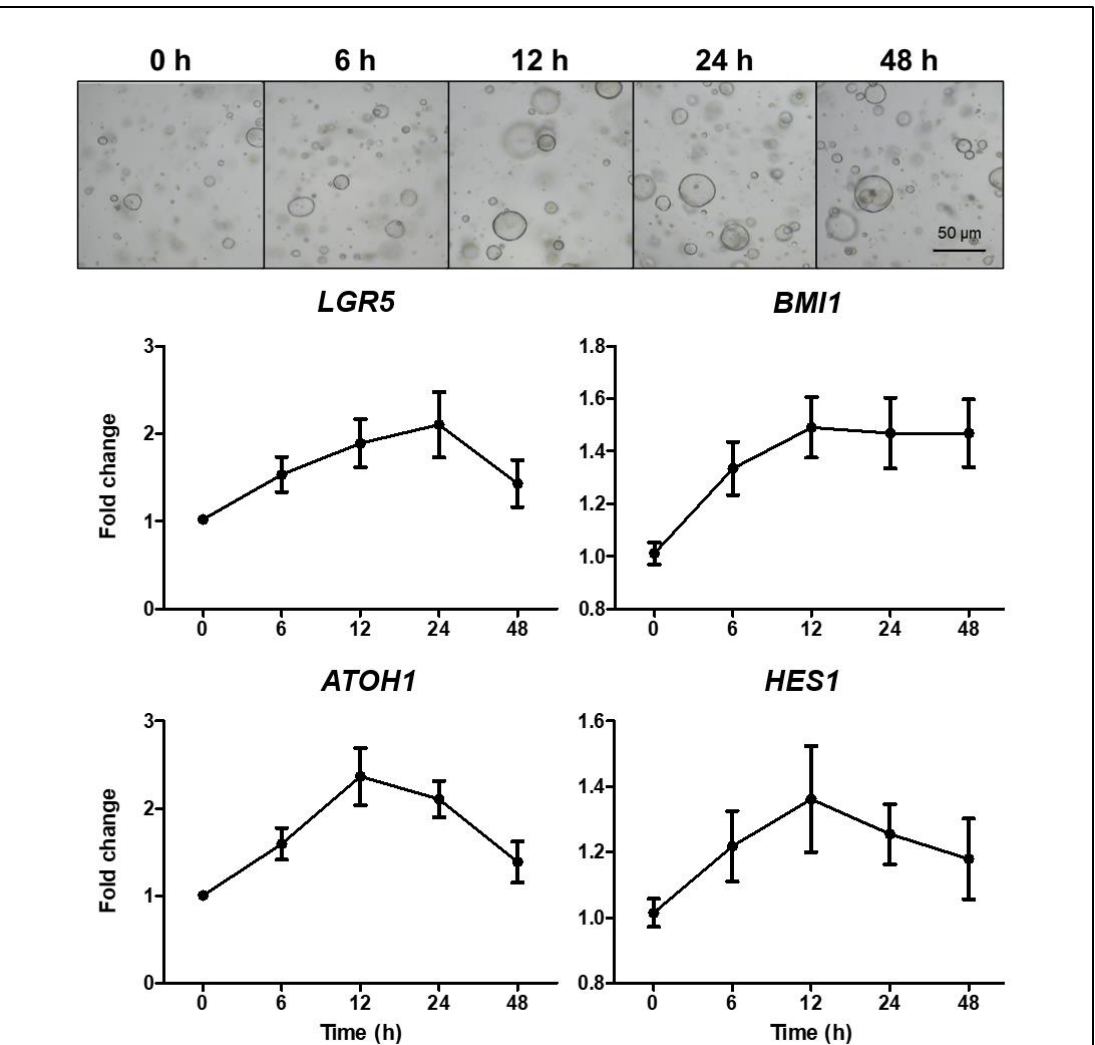
Figure 4. Changes in the expression of LGR5 , BMI1 , ATHO1 , and HES1 in control organoids at 6, 12, 24, and 48 h after treatment with TNFα (30 ng/mL). Quantitative reverse transcription polymerase chain reaction was performed with control organoids ( n = 3) in triplicate.